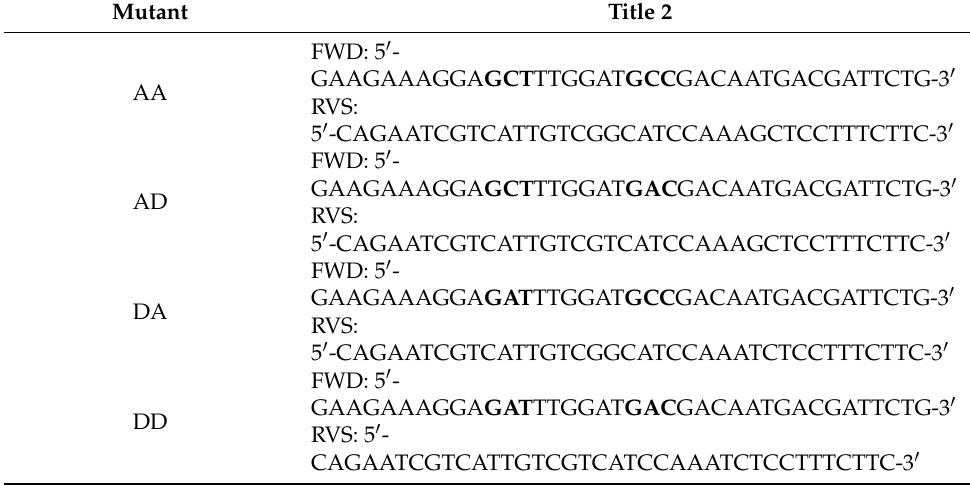
Table 1. Mutagenesis primers used to generate (de)phosphomimetic mutants of NBCe1. Bolded text in the FWD primer shows the location of the codon 982 and 985 that were the subjects of mutagenesis.